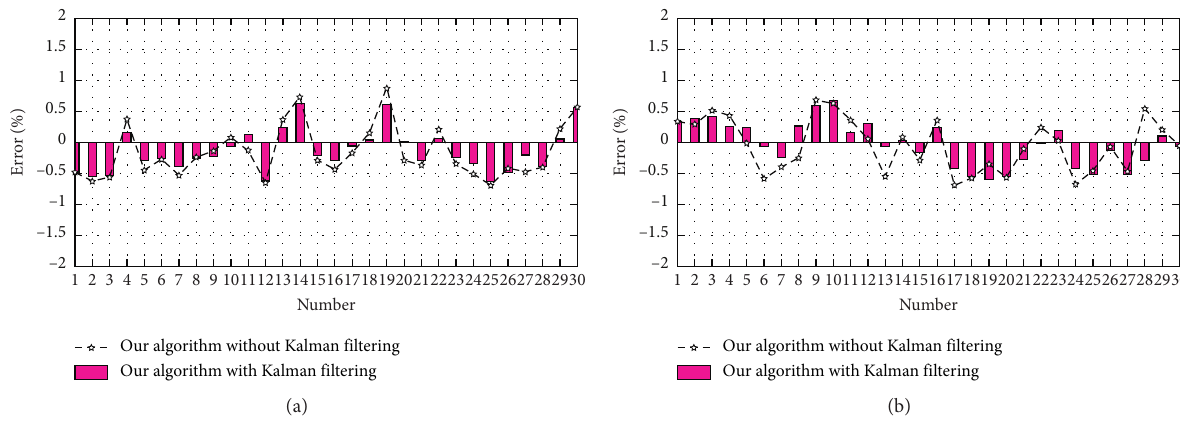
Figure 12: The error plot of women in the six consecutive seconds. (a) The woman with static height of 1648. (b) The woman with static height of 1629.